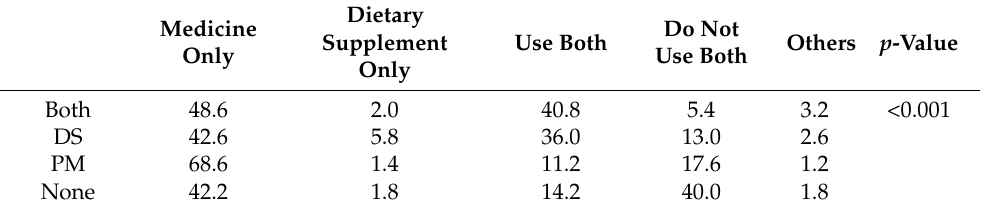
Table 7. Attitude towards dietary supplement advertisements in the hypothetical